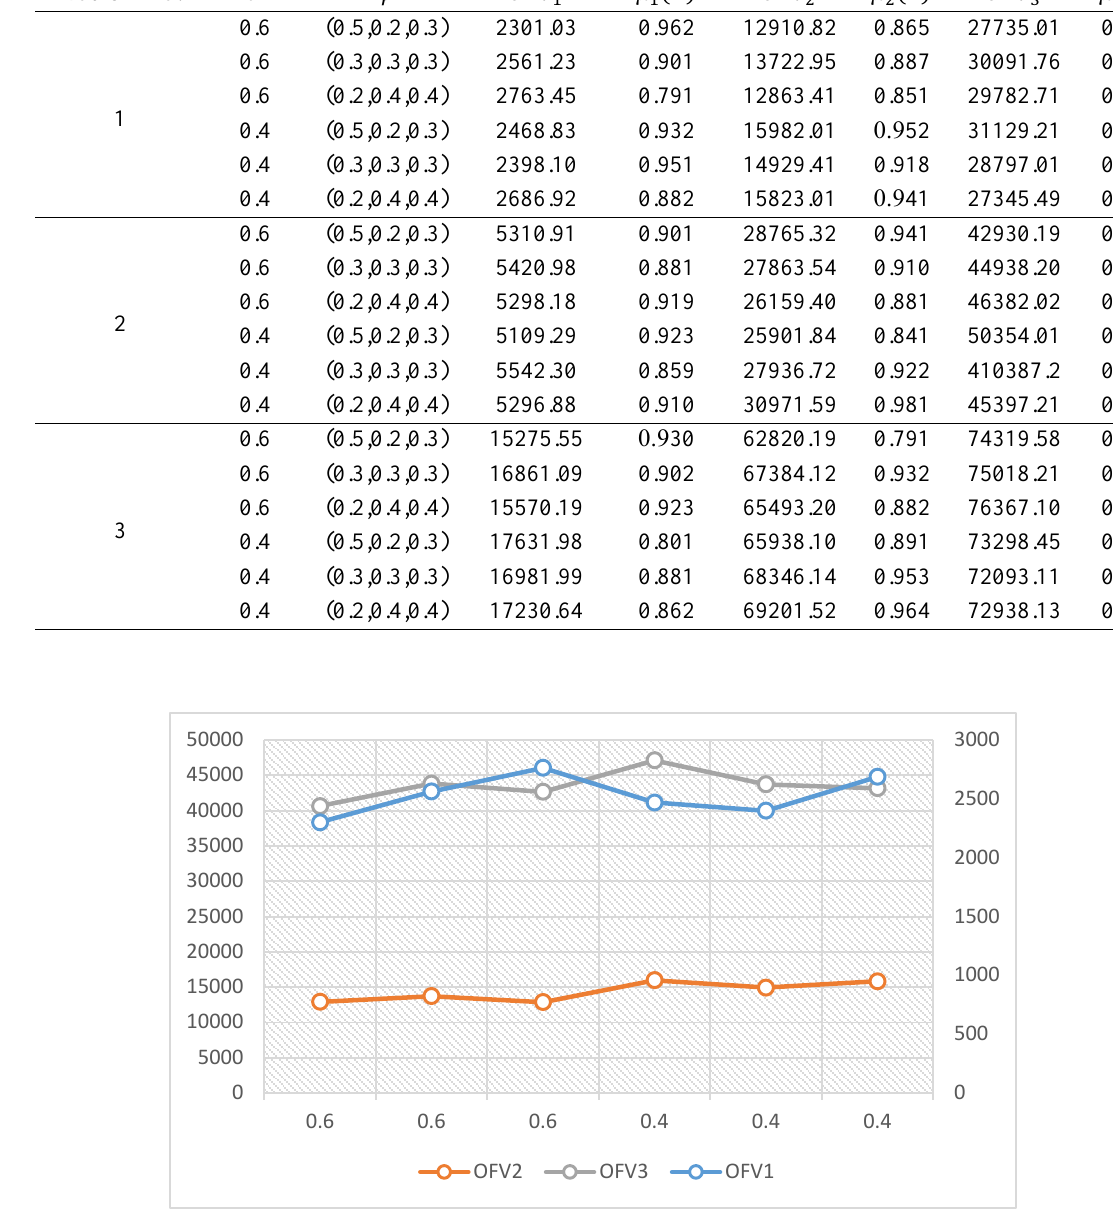
Figure 8. Objective function values of the TH method for test problem